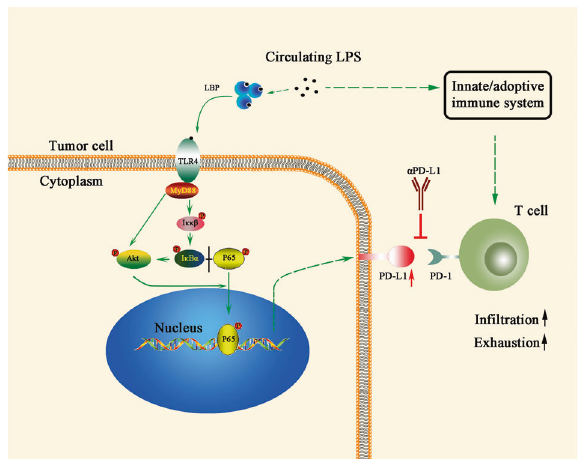
Fig. 7 The schematic drawing of LPS function in PDAC. Gut- derived LPS is double-edged sword to PDAC, which induced T cell in fi ltration in tumor microenvironment and promoted PD-L1- mediated immune evasion as well. Resultantly, LPS had synergistic effect with PD-L1 blockade in